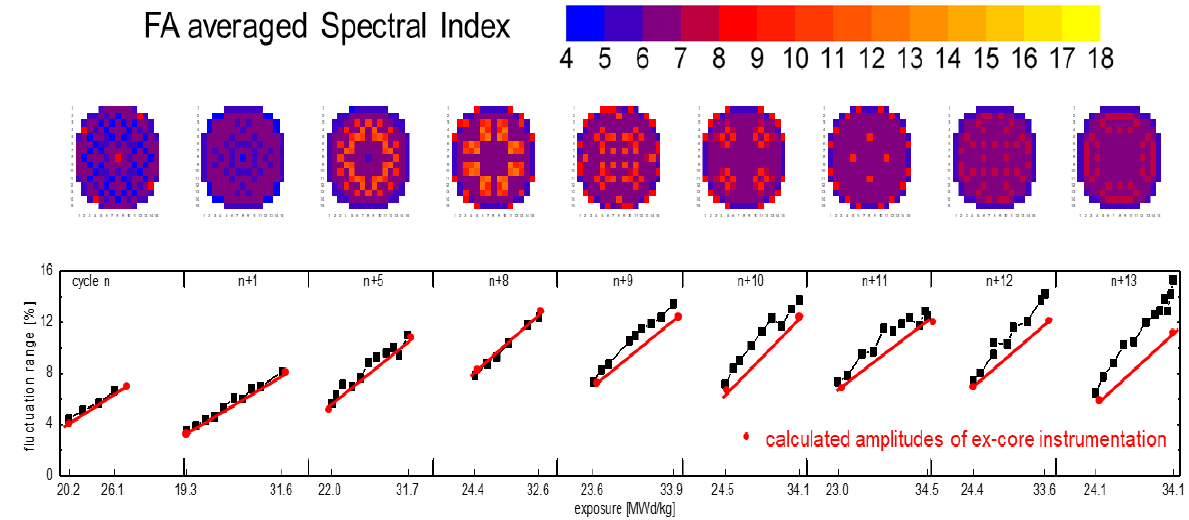
Figure 3. Evolution of the Spectral Distribution of the Neutrons compared to the observed and calculated Evolution of the NFN